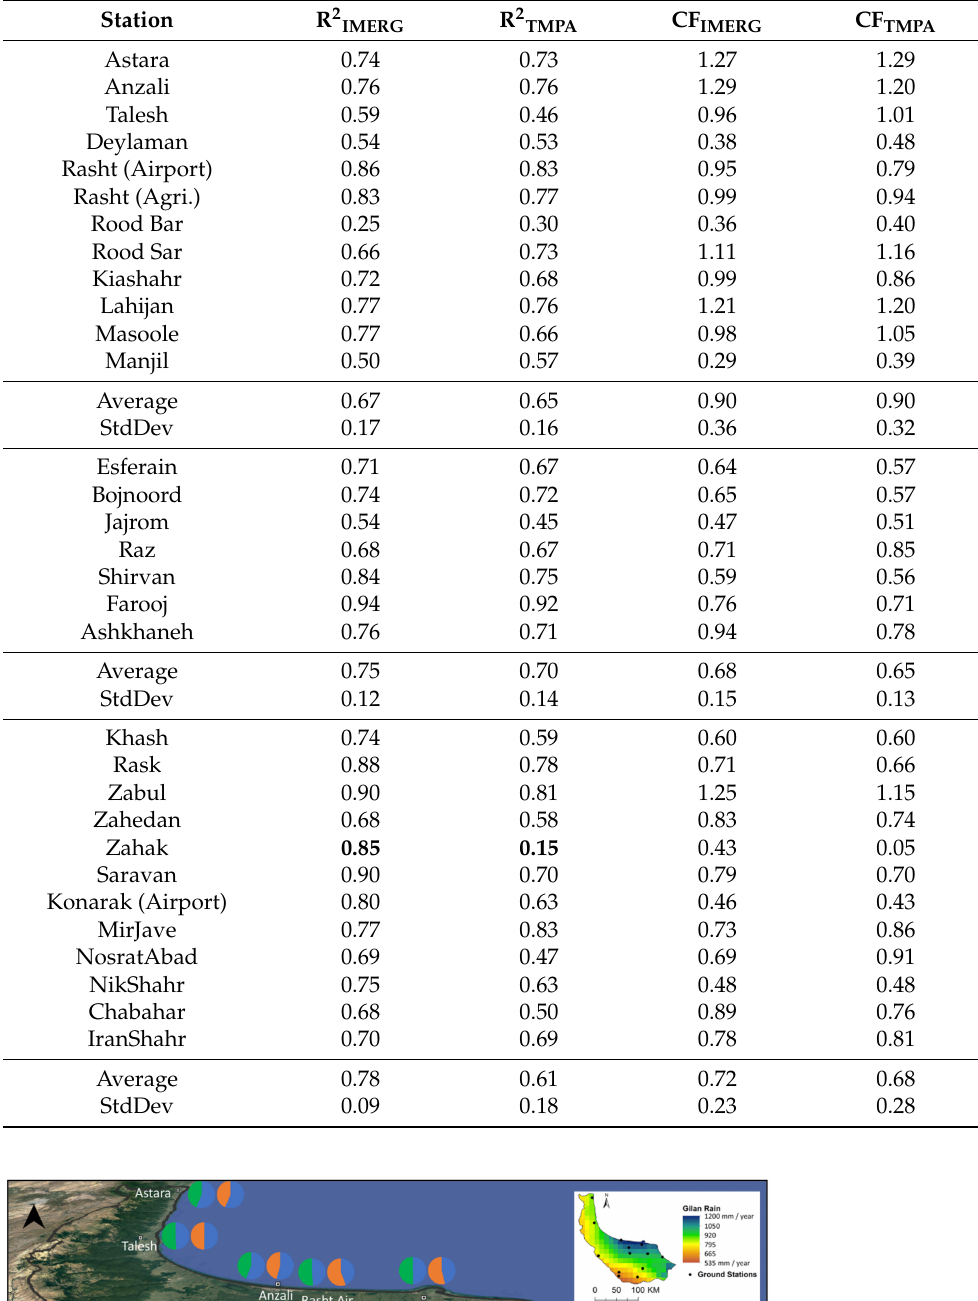
Table 3. R-squared and correction factors of IMERG and TMPA in ground stations.